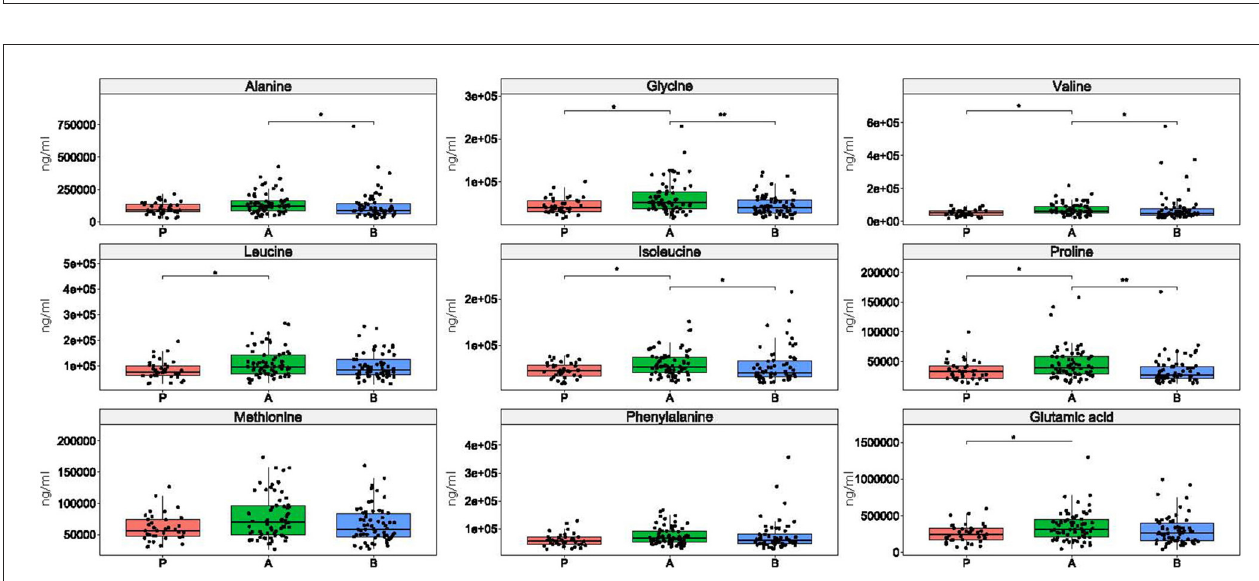
FIGURE7 Differences in amino acid concentration between enterotypes. *: p ≤ 0.05, **: p ≤ 0.01.